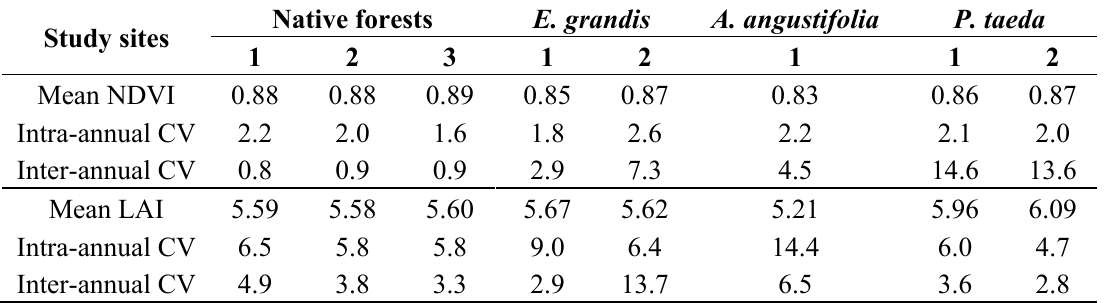
Table 3. Mean annual NDVI (Normalized Difference Vegetation Index) and LAI (Leaf Area Index) values obtained from remote sensing and their intra-annual and inter-annual coefficients of variation (CV, %) for three native forest stands and two Eucalyptus grandis , two Pinus taeda and one Araucaria angustifolia tree